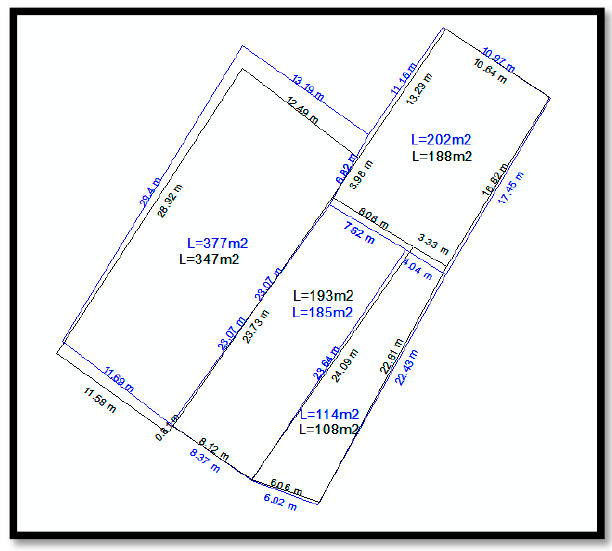
Figure 4. Visualization of differences in the results of evaluation (blue) and reference (black) polygonal data in the study area of Tanggamus pilot .